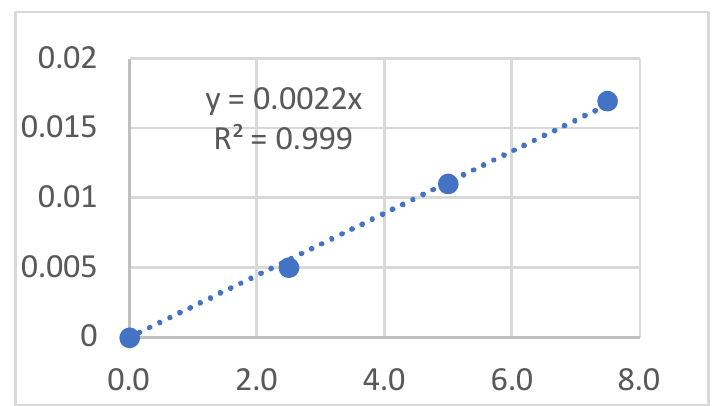
Figure 1. Pb calibration graphs.